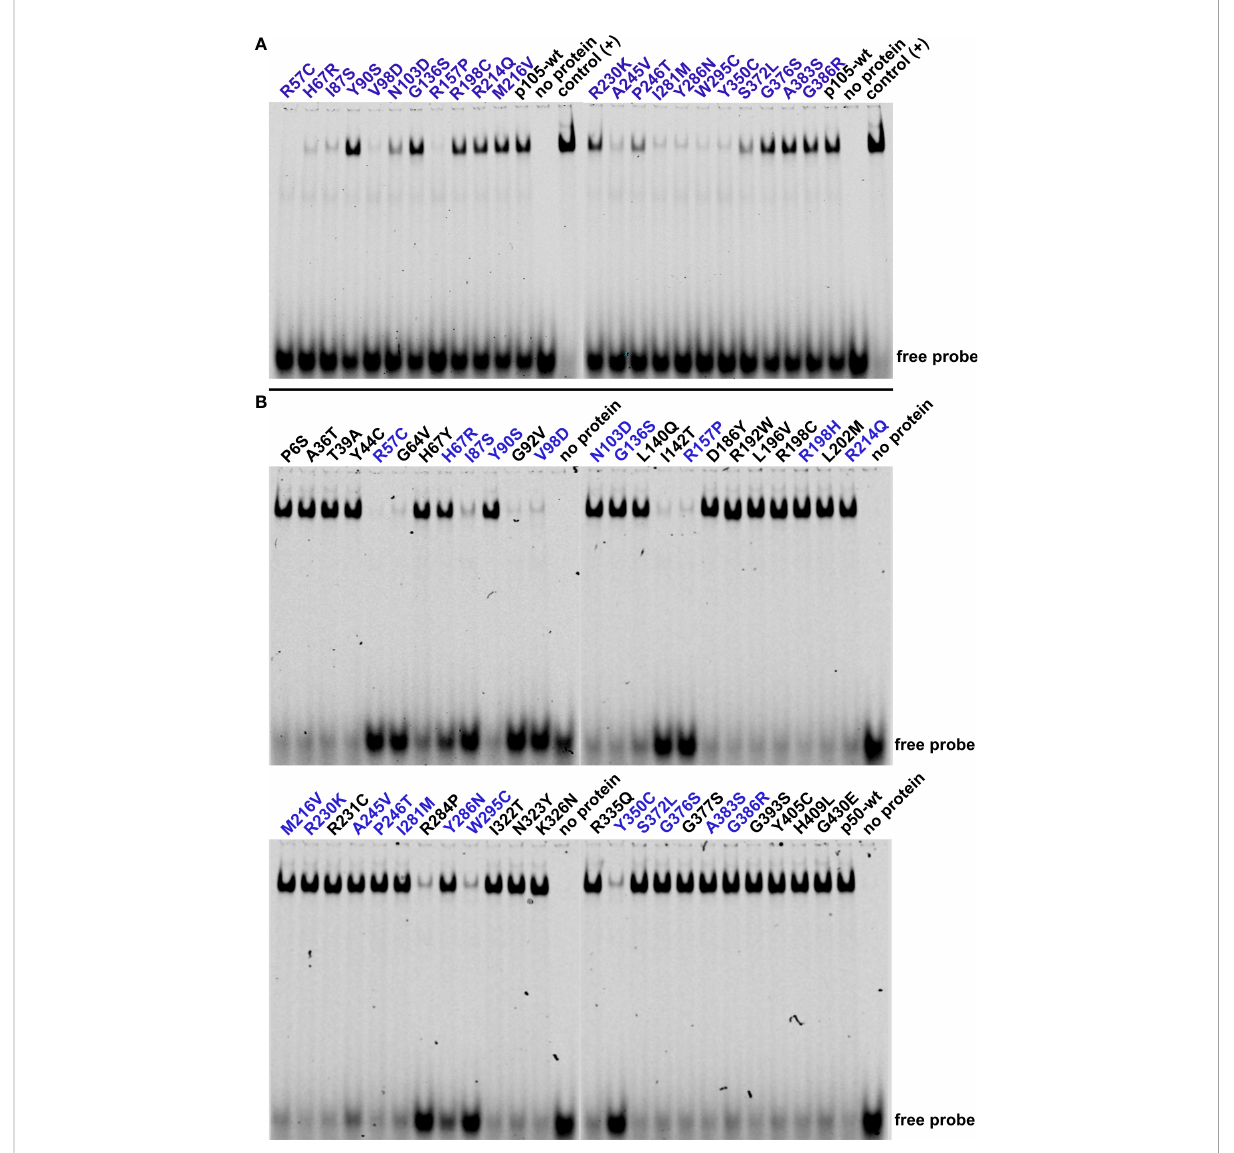
FIGURE 4 Impaired p50-mediated DNA-binding activity uncovers deleterious NFKB1 mutations and loss-of-function variants. HEK293T cells were transiently transfected with the indicated p105 or p50 variants. NF- k B DNA-binding activities were determined by EMSA using nuclear extracts. (A) In cells transfected with p105 expression constructs, nuclear DNA-binding activity originates from cell-intrinsic generation of p50 by processing of precursor proteins. Reduced or absent DNA-binding denotes decaying and DNA-binding de fi cient variants or might indicate subtle defects e.g. related to processing or nuclear transfer. Please note the consumption of the free probe when using overexpressed p50 as positive control. Representative results of three independent experiments are shown. Electrophoresis was carried out twice. (B) Immediate expression of p50 (i.e. not generated via precursor processing) indicates deleterious p50 defects and DNA-binding-de fi ciency. Please note the reduced size of the shifted band with the R192W variant. Representative results of fi ve independent experiments are